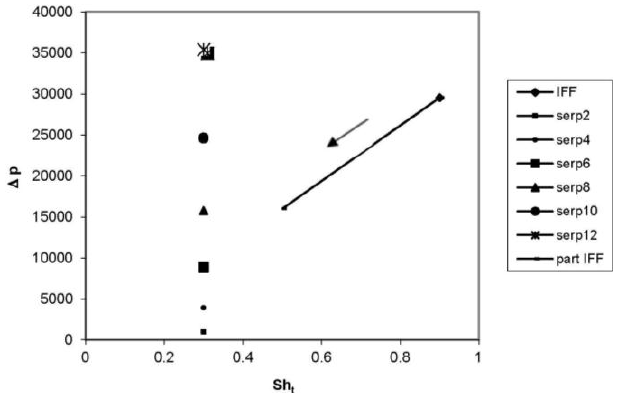
Figure 10. A comparison of the running conditions, in terms of head losses and diffusive resistances, for different electrode arrangements. Serpentine (serp with number of zigzag), interdigitated flow field (IFF) and partially interdigitated (part IFF) configurations are considered. (B/D = 1; H/D = 0.1; permeability parameter =0.35).